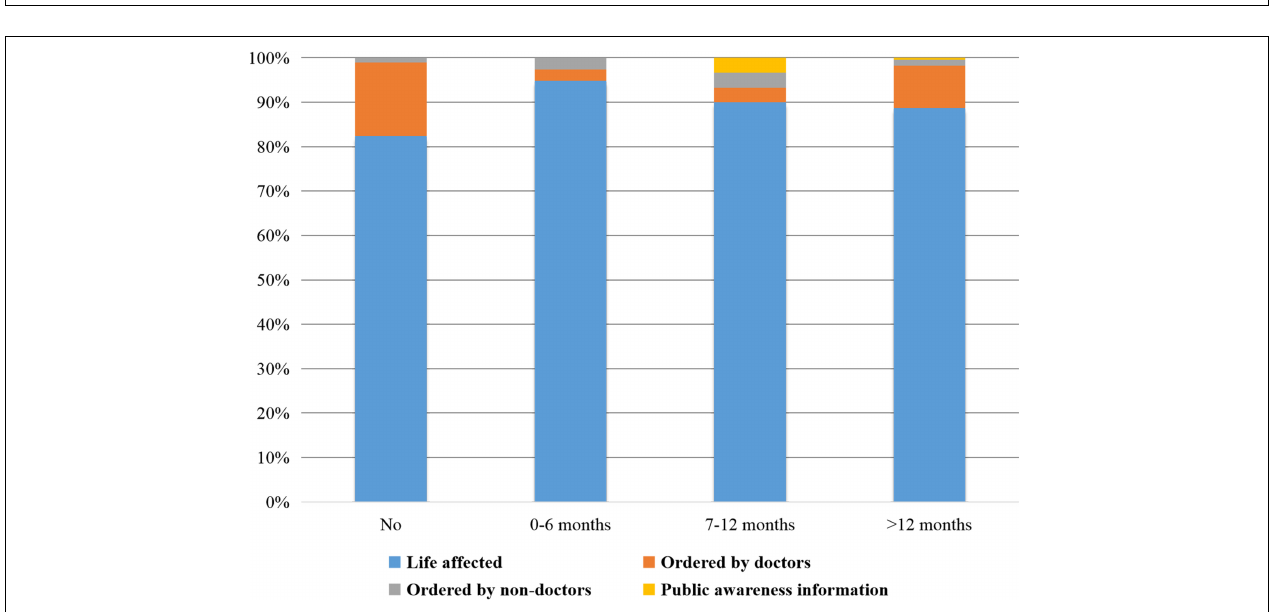
FIGURE 1 | Distribution of durations of delaying surgery treatment and reasons for it. A total of 298 (74.50%) participants delayed surgery, and 229 (57.25%) delayed it for more than 12 months. The reasons why patients delayed surgery exhibited distributional differences among four groups ( P < 0.001). There were 114